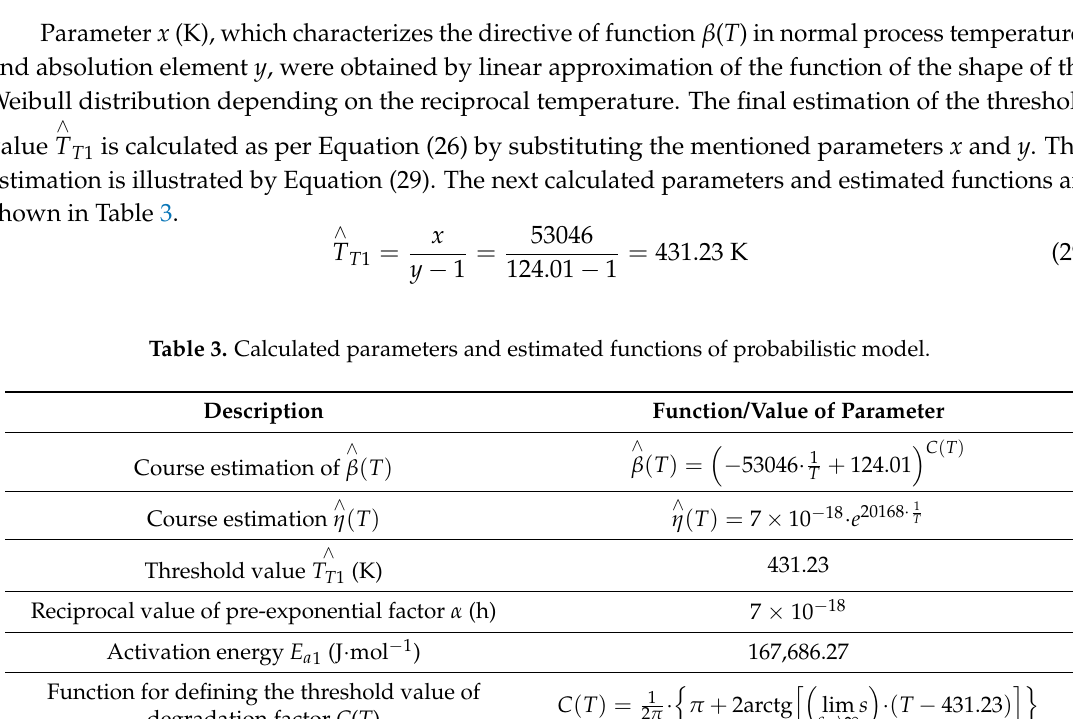
Figure 10. Parameter of the scale of the Weibull distribution depending on the reciprocal temperature.